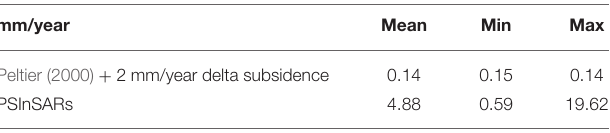
TABLE 3 | Comparison between mean, maximum and minimum values of the globally modeled and locally measured vertical land movement data for the study area.